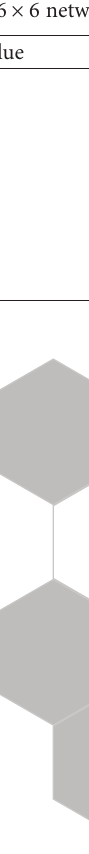
Figure 4: 4 × 4 test network optimal solution with reporting cells